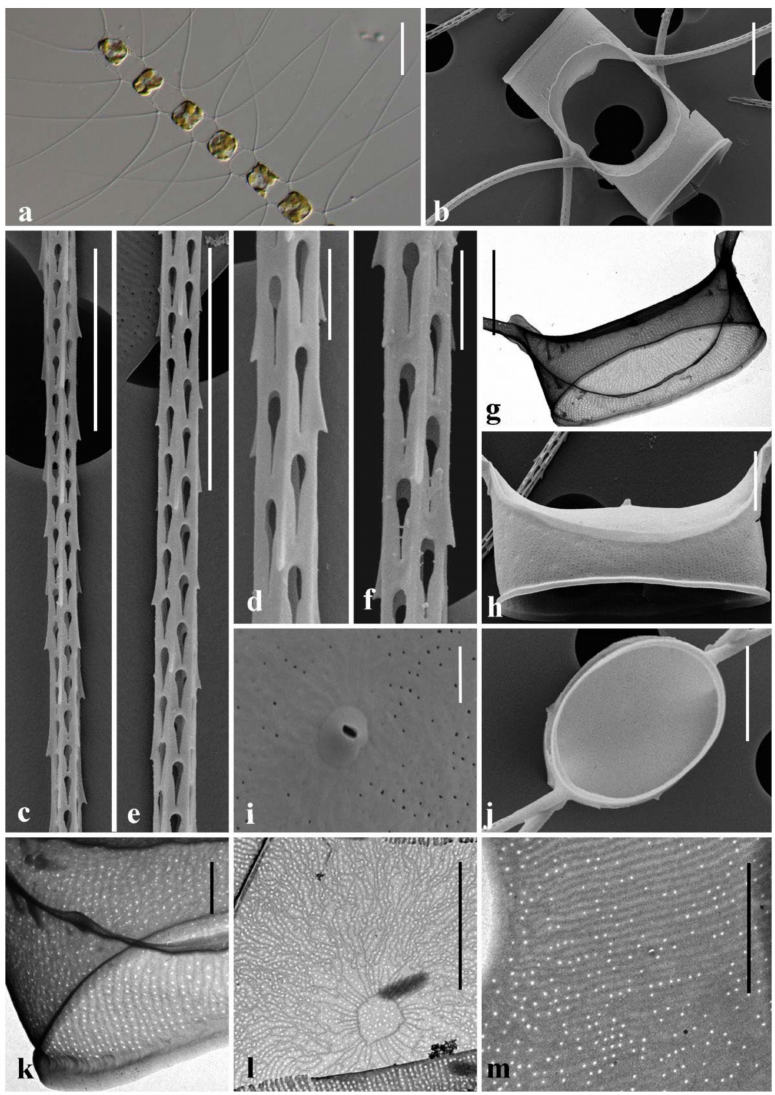
Figure 1. LM ( a ), SEM ( b – f , h – j ) and TEM ( g , k – m ) micrographs of Chaetoceros elegans , strain YL7. ( a ) Chain in broad girdle view; ( b ) sibling intercalary valves showing setae base and aperture; ( c – f ) poroids and spines on terminal ( c , d ) and intercalary setae ( e , f ); ( g , h ) terminal valves; ( i ) close-up of rimoportula; ( j ) intercalary valve view; ( k ) rows of poroids on the mantle; ( l ) central annulus on intercalary valve; ( m ) close-up of bands. Scale bars: ( a ) 20 µ m; ( b – d , g , h , j , l ) 5 µ m; ( e , f , i , k , m ) 1 µ